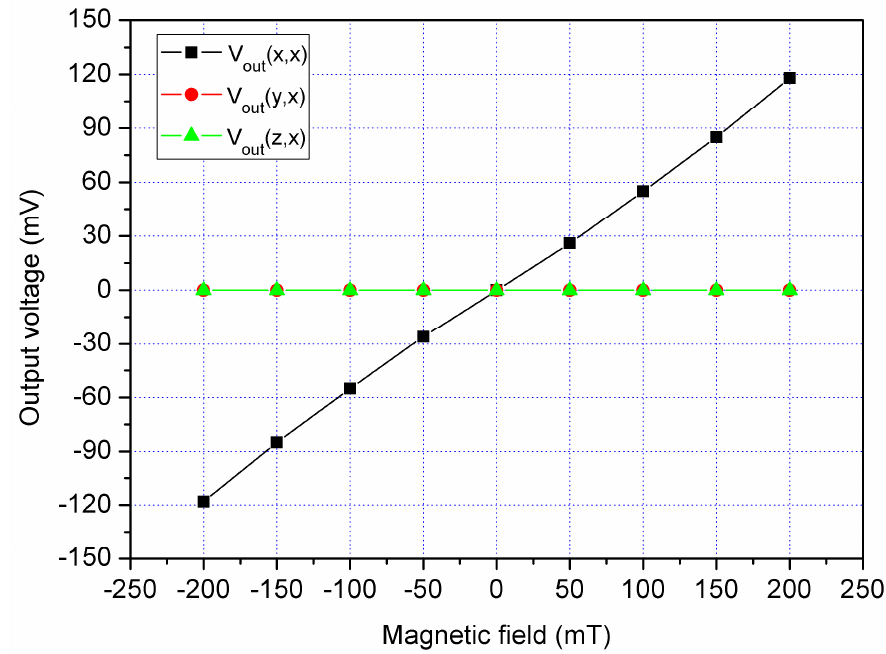
Figure 6. Simulation of output for the MS in the x-direction MF.